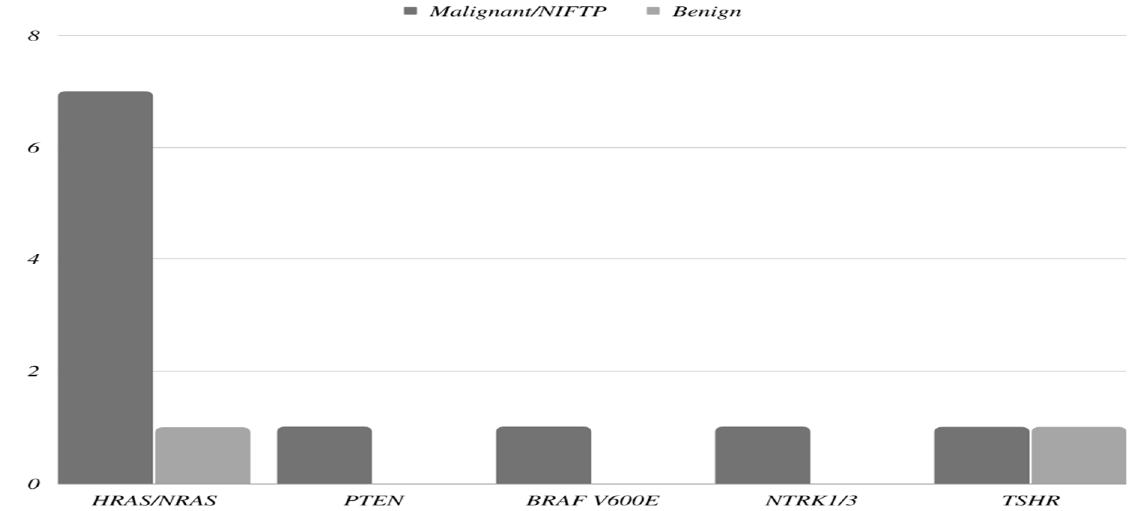
Figure 2. Prevalence of an additional molecular alteration and GEA based on tumor type.